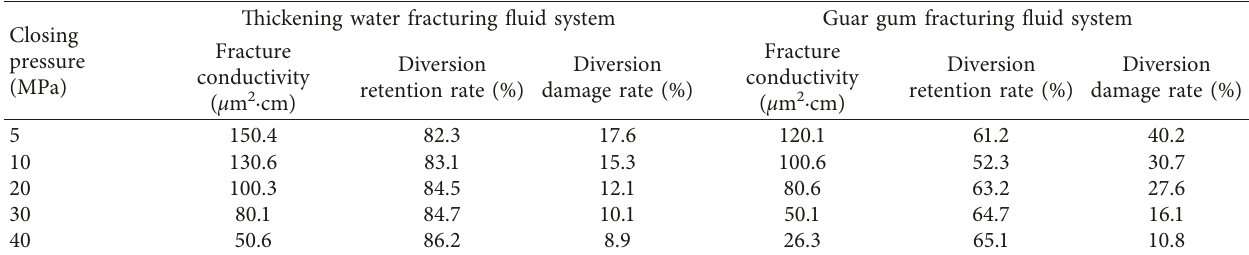
Table 4: Comparison of three properties of two kinds of fracturing fluids.